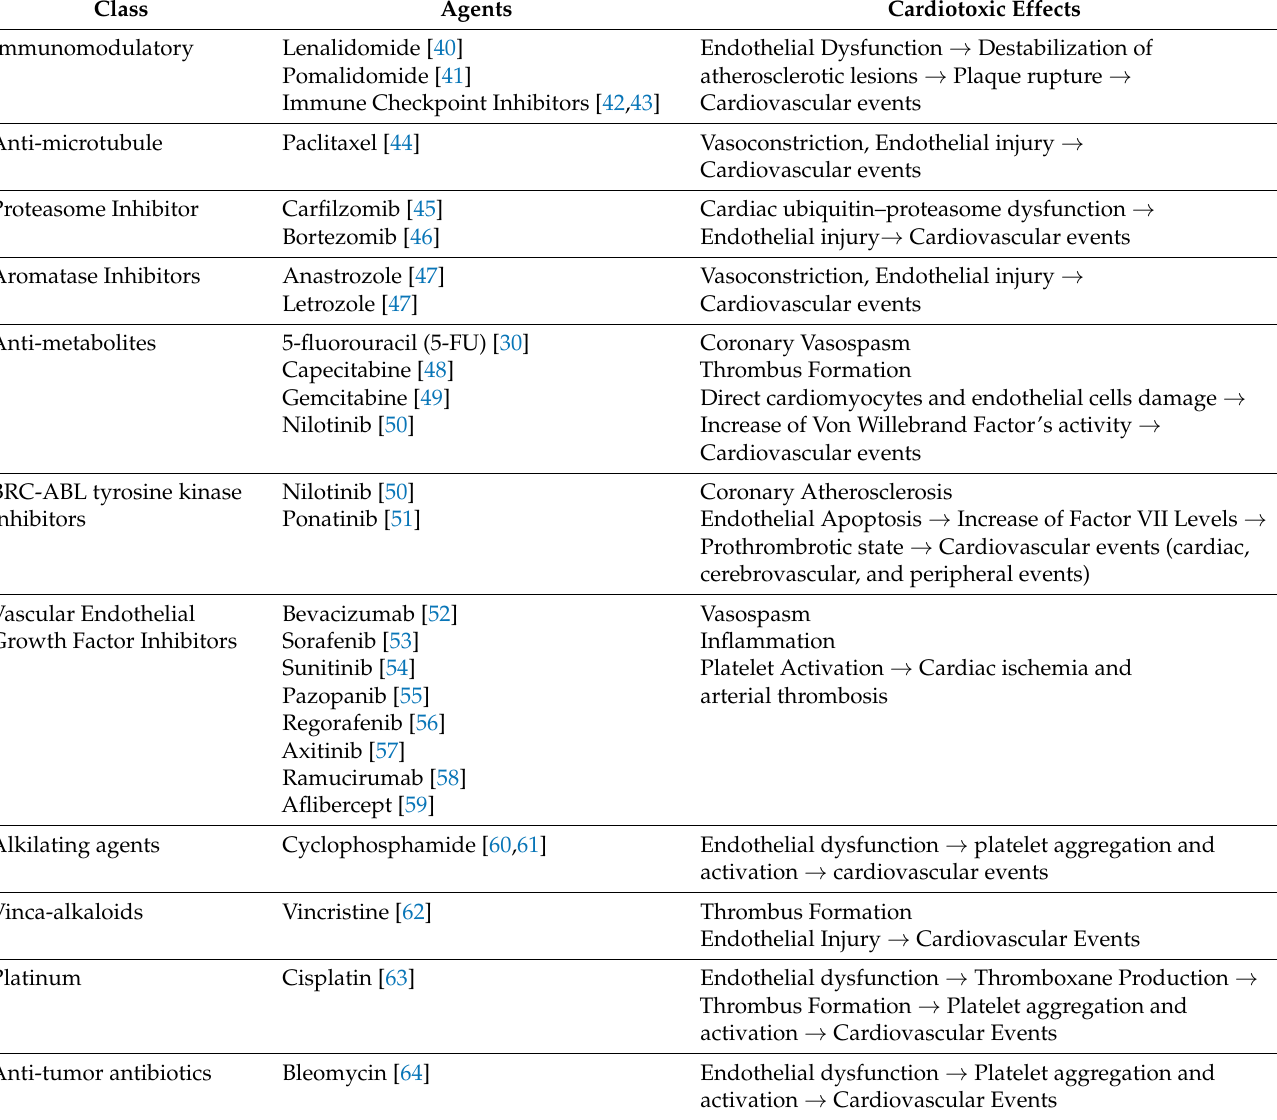
Table 1. Mechanism of Antineoplastic Drug-Induced